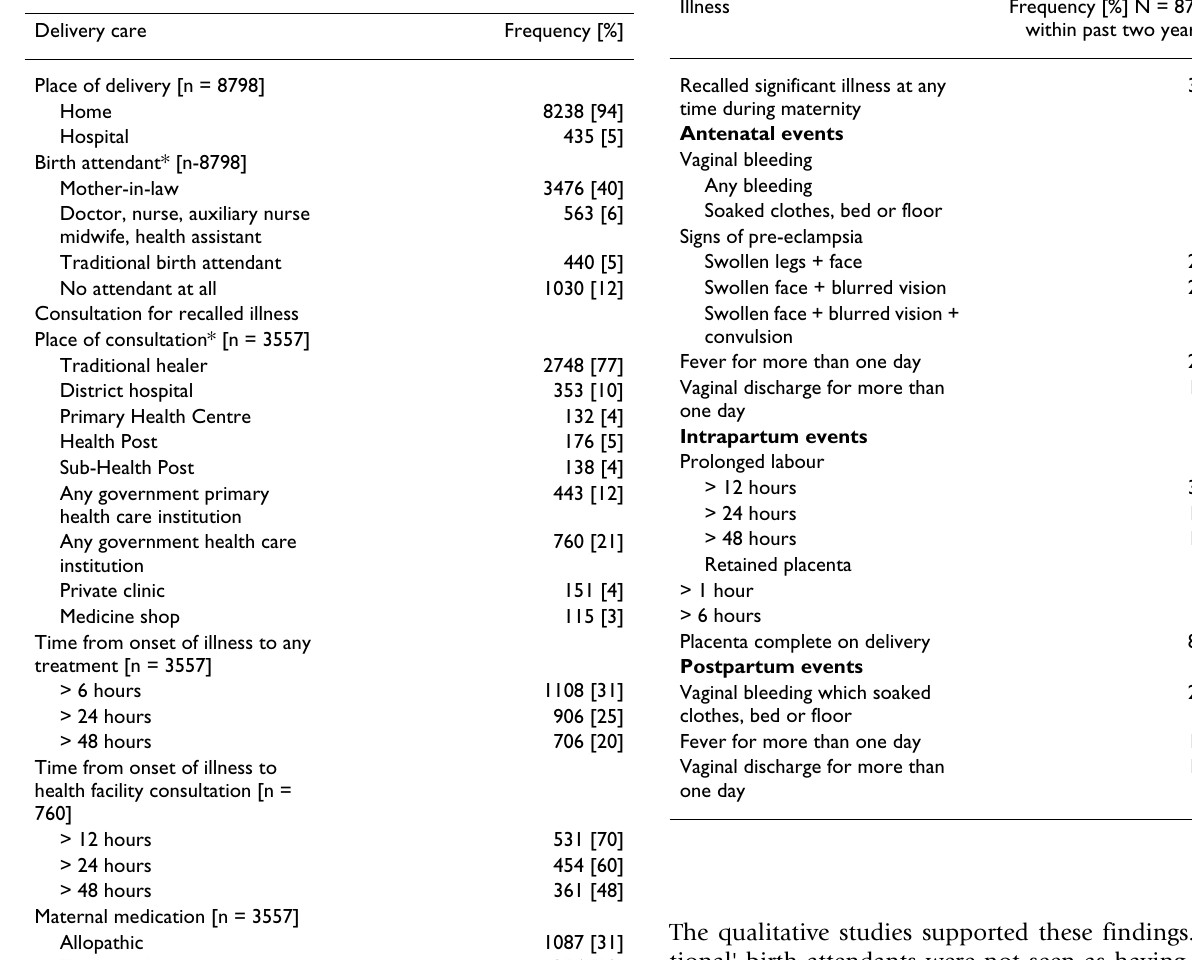
Table 3: Maternal illness findings from the survey questionnaire